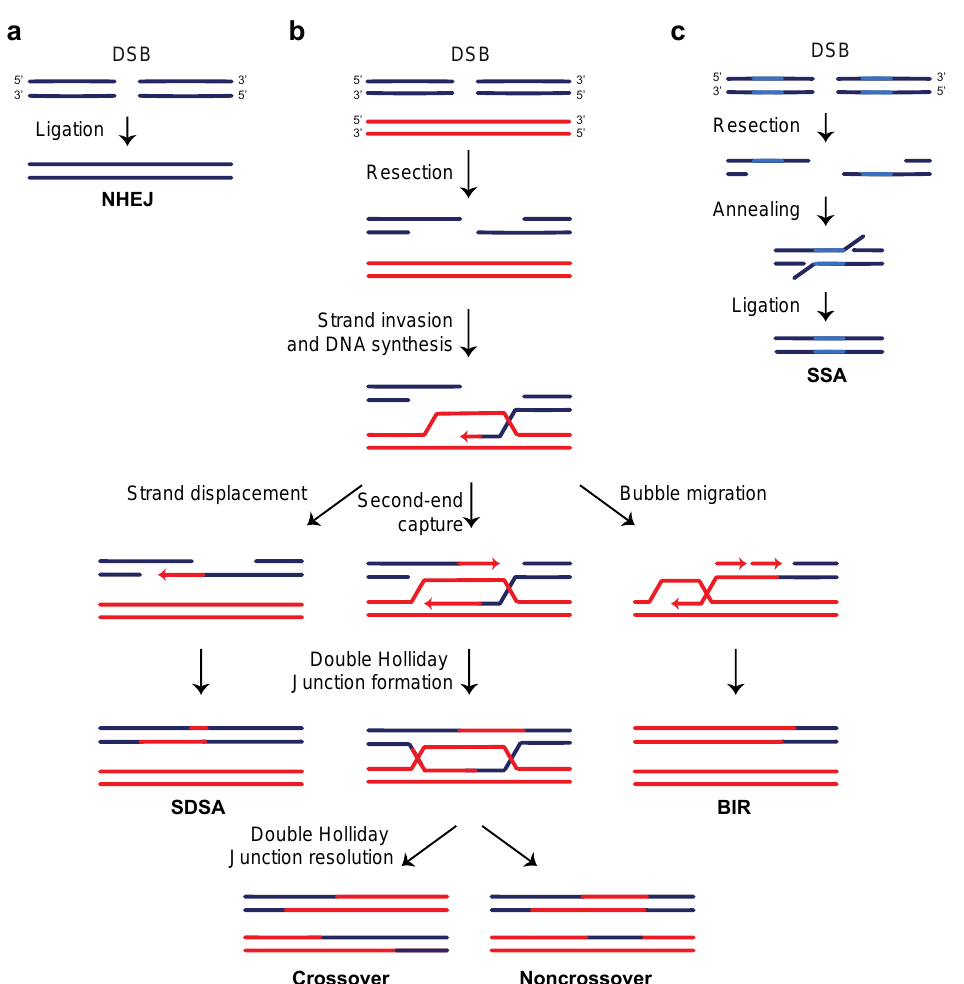
Figure 1. Mechanisms of DSB repair. ( a ) Non-homologous end joining (NHEJ) directly rejoins the two broken ends together. ( b ) Resection generates a 3 (cid:48) -ended ssDNA tail (in dark blue) that invades a homologous duplex (in red) and stimulates DNA synthesis. If the elongating strand re-anneals with the broken template, DSB is repaired by synthesis-dependent strand annealing (SDSA), thus generating only non-crossover products ( left ). If the intermediate is stabilized by a second-end capture, a double Holliday junction is formed. The resolution of this intermediate generates both crossover and non-crossover products ( center ). A failure to engage the second DSB end leads to break-induced replication (BIR). The 3 (cid:48) overhang that has invaded the homologous template triggers bubble migration and extensive DNA synthesis that can proceed until the end of the chromosome ( right ). ( c ) A DSB between two homologous sequences (in light blue) can be repaired by single-strand annealing (SSA). When resection generates ssDNA at the homologous sequences, they can anneal to each other. Subsequent ligation causes the deletion of one of the homologous sequences and of the intervening sequence.